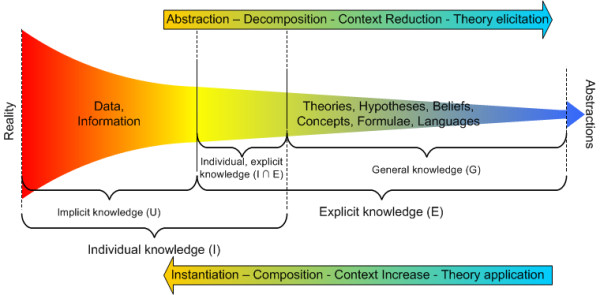
The knowledge spectrum.